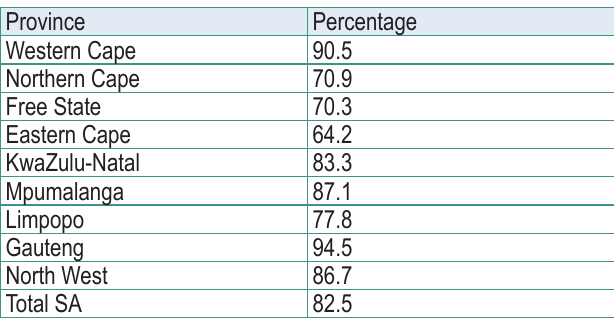
Table 2: Percentage households with access to sanitation (1996)